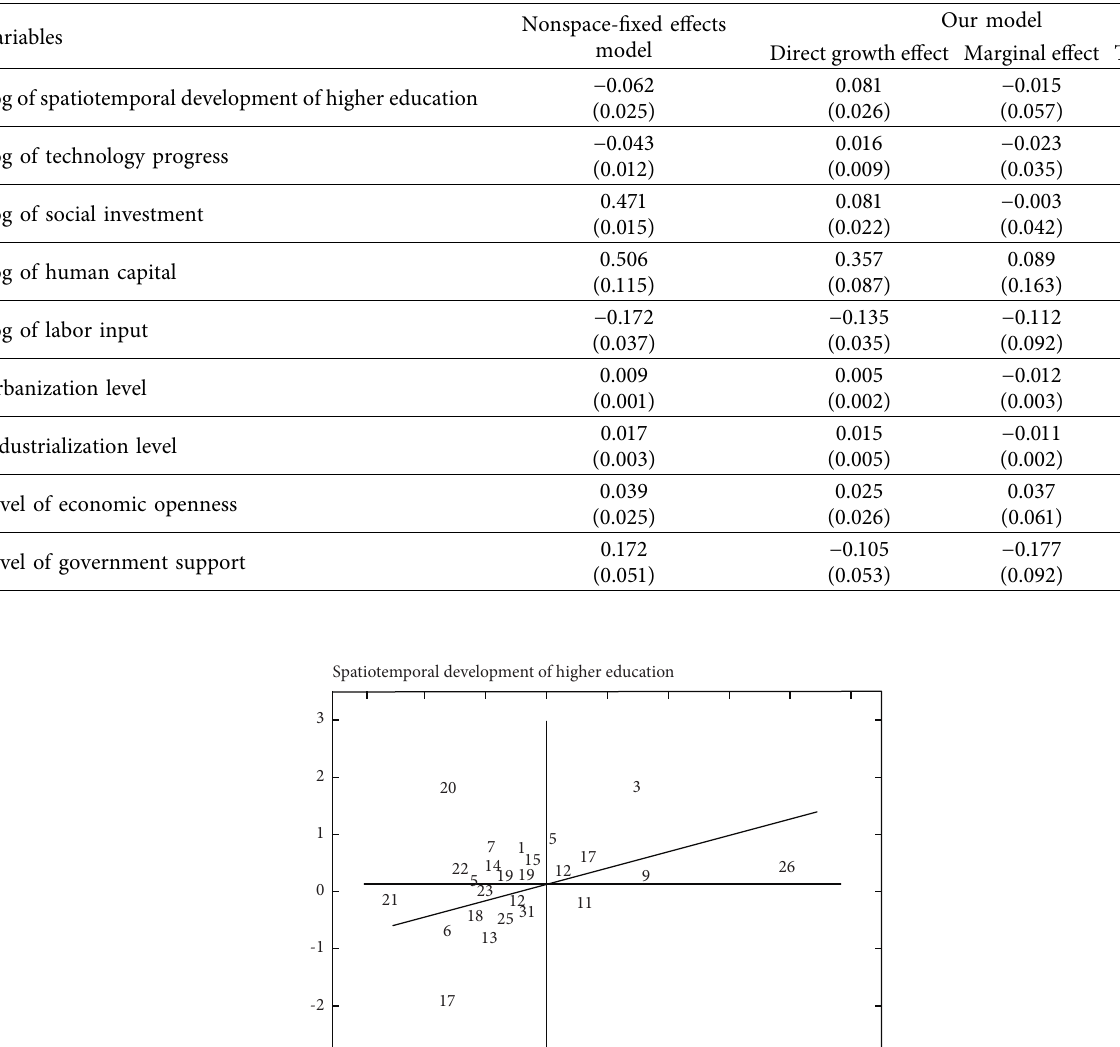
Table 4: Influence of spatiotemporal development of higher education on regional economy.